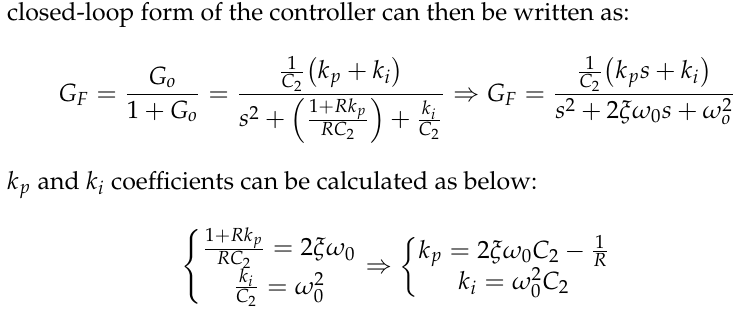
Figure 5. The proposed DC – DC converter circuit and controller.